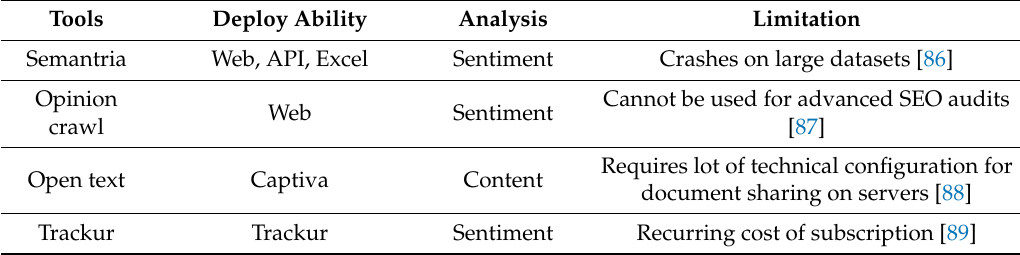
Table 7. Comparison of data collection